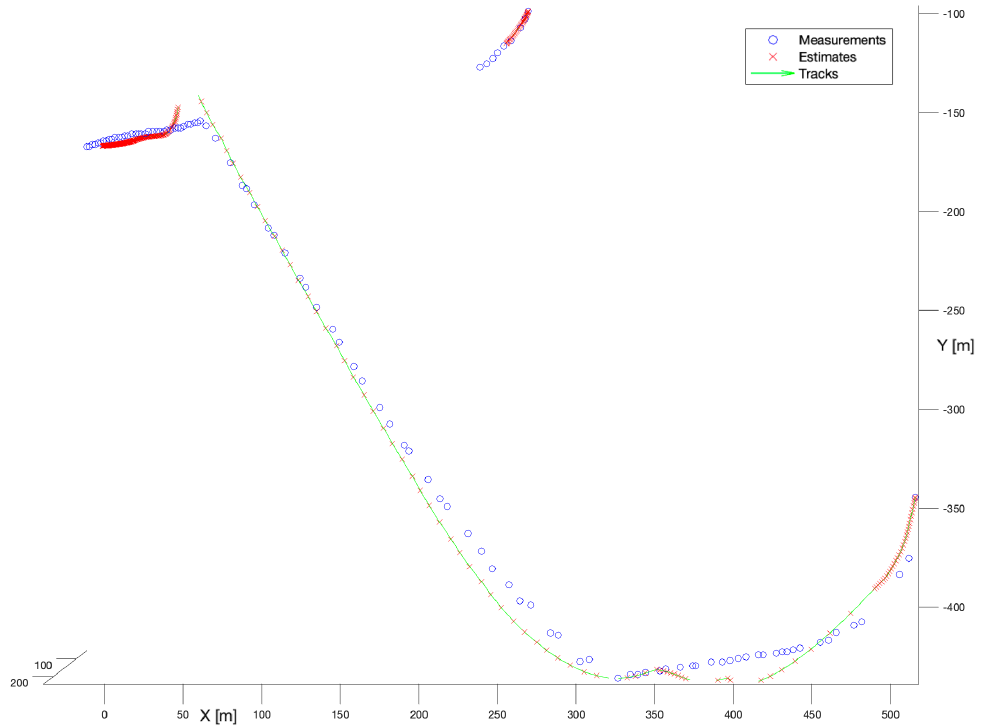
Figure 10. Kalman Filter + Joint Probabilistic Data Association. Multiple bird flight